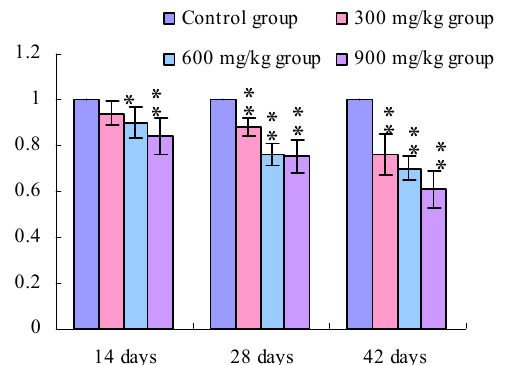
Figure 8. The TLR4 mRNA expression levels in the cecal tonsil in